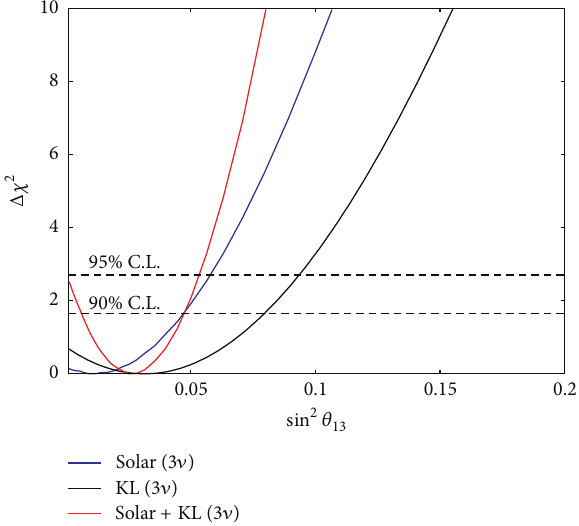
Figure 15: Projections of the three-flavor neutrino oscillation parameters. The horizontal lines represent the Δ𝜒 2 for a particular confidence level. Taken from